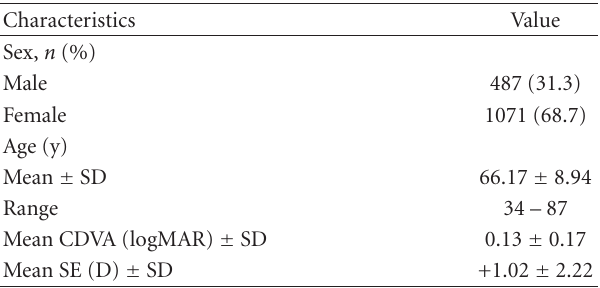
Table 1: Preoperative characteristics of the patients ( N = 1558).